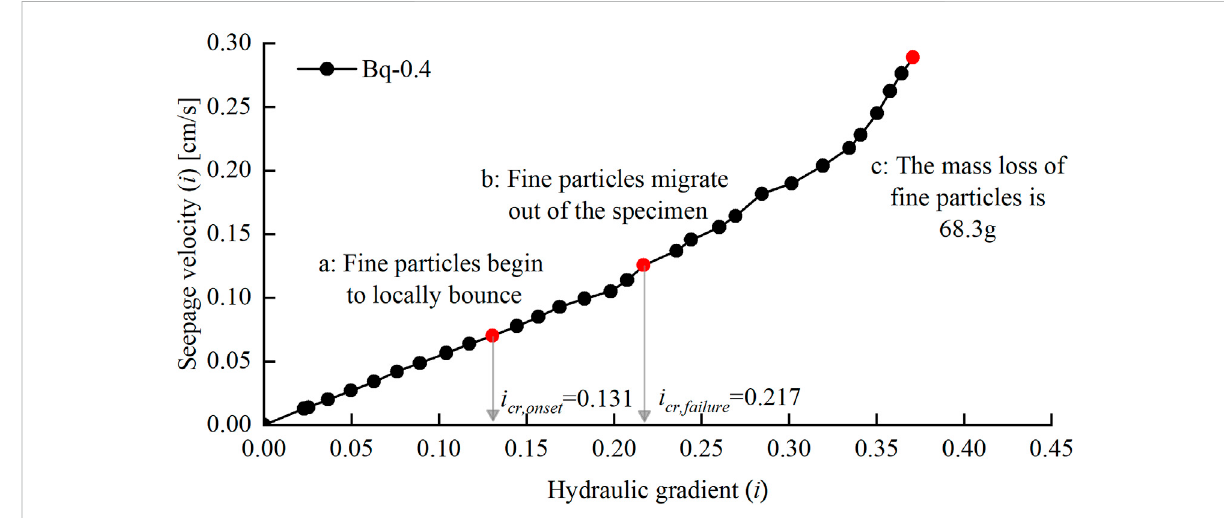
FIGURE 12 i – v curve for test